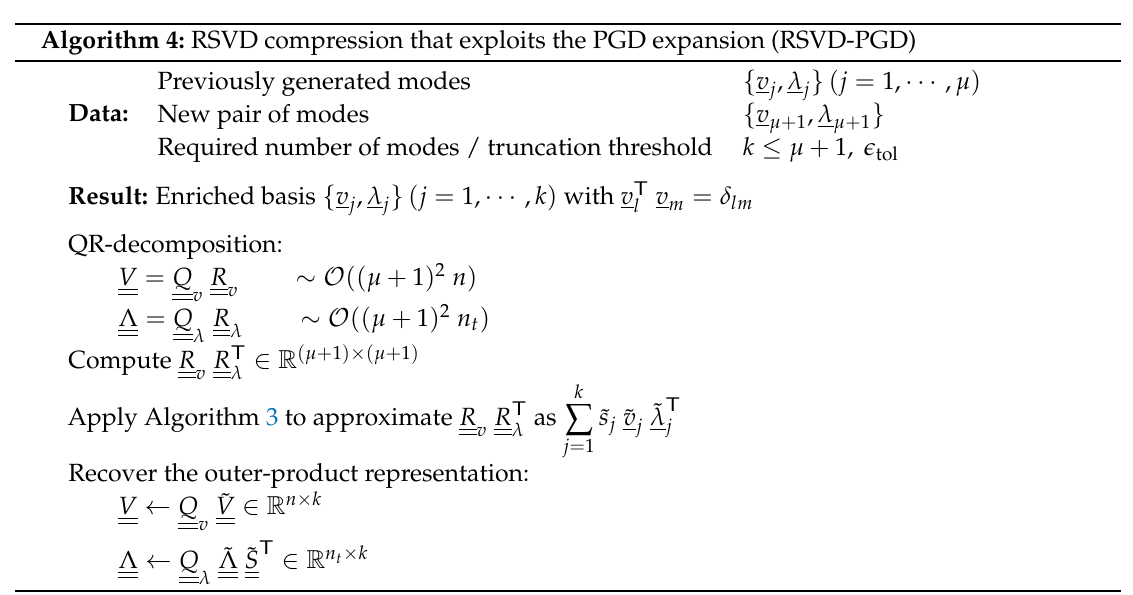
Algorithm 4: RSVD compression that exploits the PGD expansion